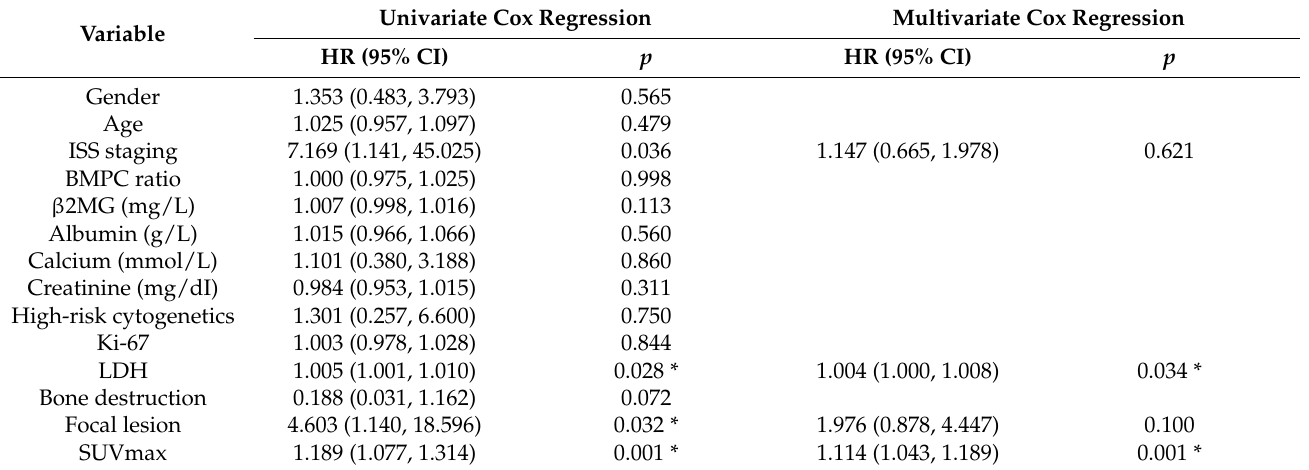
Table 2. Univariate and multivariate Cox analysis for PFS in the training and validation cohorts for patients with